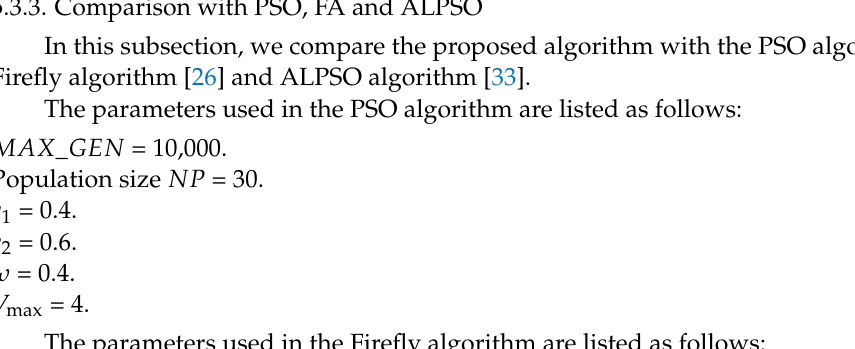
Figure 8. The average number of generations obtained by NSDE and SaNSDE with LP = 1000 for Case 6, Case 7, Case 8, Case 9 and Case